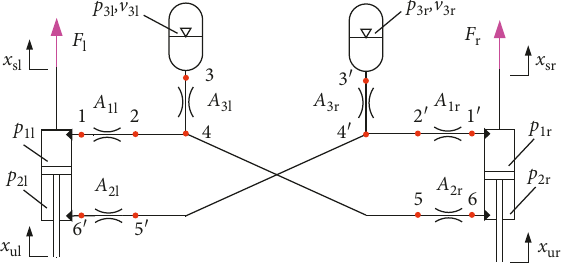
Figure 1: Vehicle dynamics model for the HIS system.